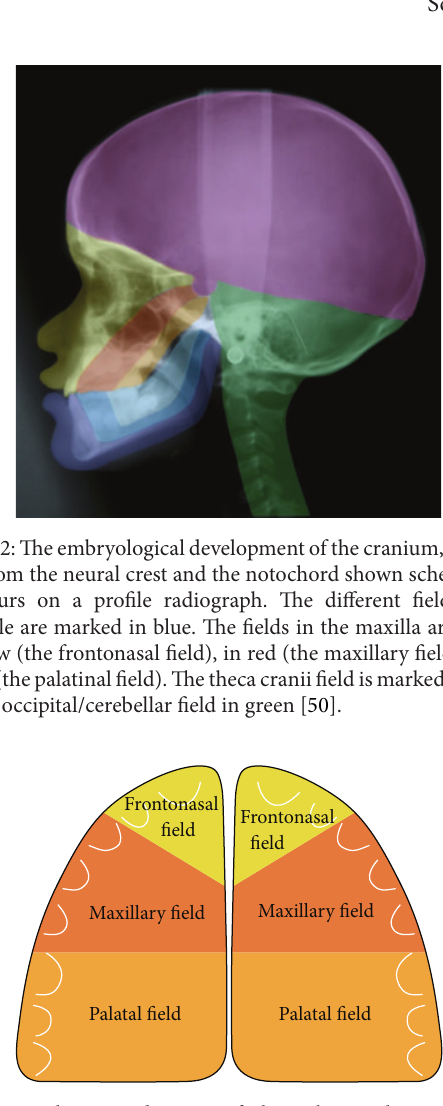
Figure 3: Schematic drawing of the palate. White semicircles mark the location of the maxillary teeth according to the coloured maxillary fields: yellow fields indicate frontonasal fields, red fields indicate maxillary fields, and orange fields indicate palatinal fields (see Figure